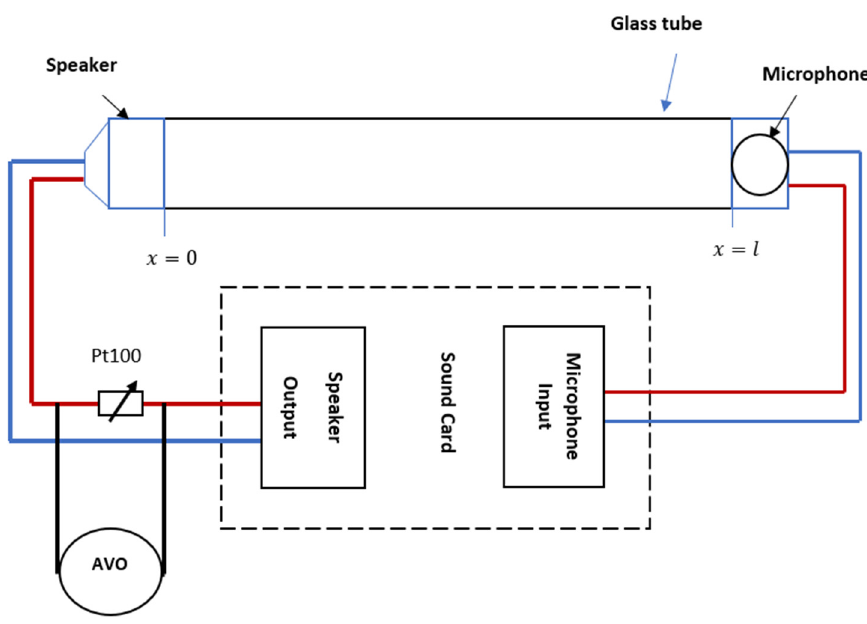
Figure 3. The connection lead wires with Pt100.